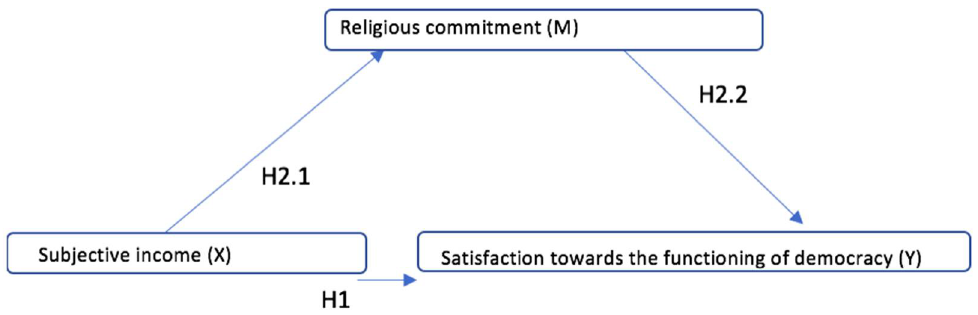
Figure 1. Hypothetical model proposed by the study.